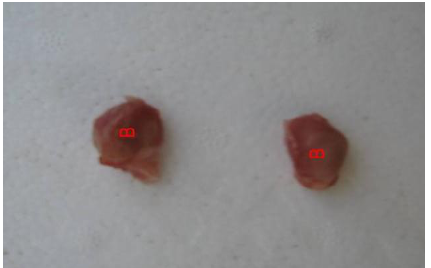
Figure 5: Vesicular gland of the buck (S) (Right and left).